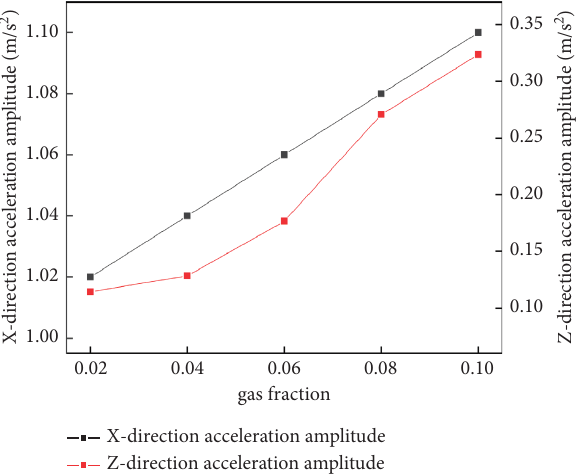
Figure 16: Variation curve of X - and Z -direction acceleration amplitude with natural gas